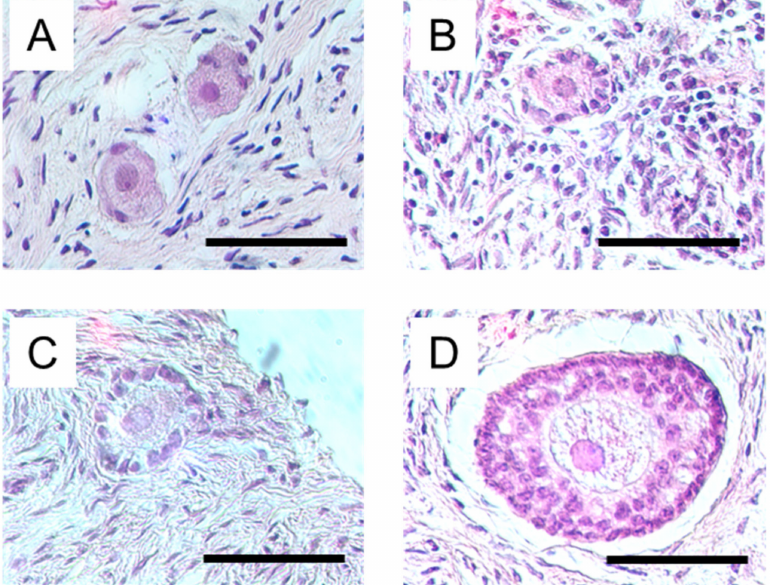
Figure 1. Photomicrographs of histological sections of follicles at each stage of development. ( A ): Pri- mordial follicles: an oocyte surrounded by a complete or incomplete single layer of a flattened granulosa cell. ( B ): Transitional follicles: oocyte surrounded by a mixed layer of flattened and cuboidal granulosa cells. ( C ): Primary follicles: oocyte surrounded by a single layer of cuboidal granulosa cells. ( D ): Secondary stage: oocyte surrounded by two or more complete layers of cuboidal granulosa cells. Scale bar = 50 µ